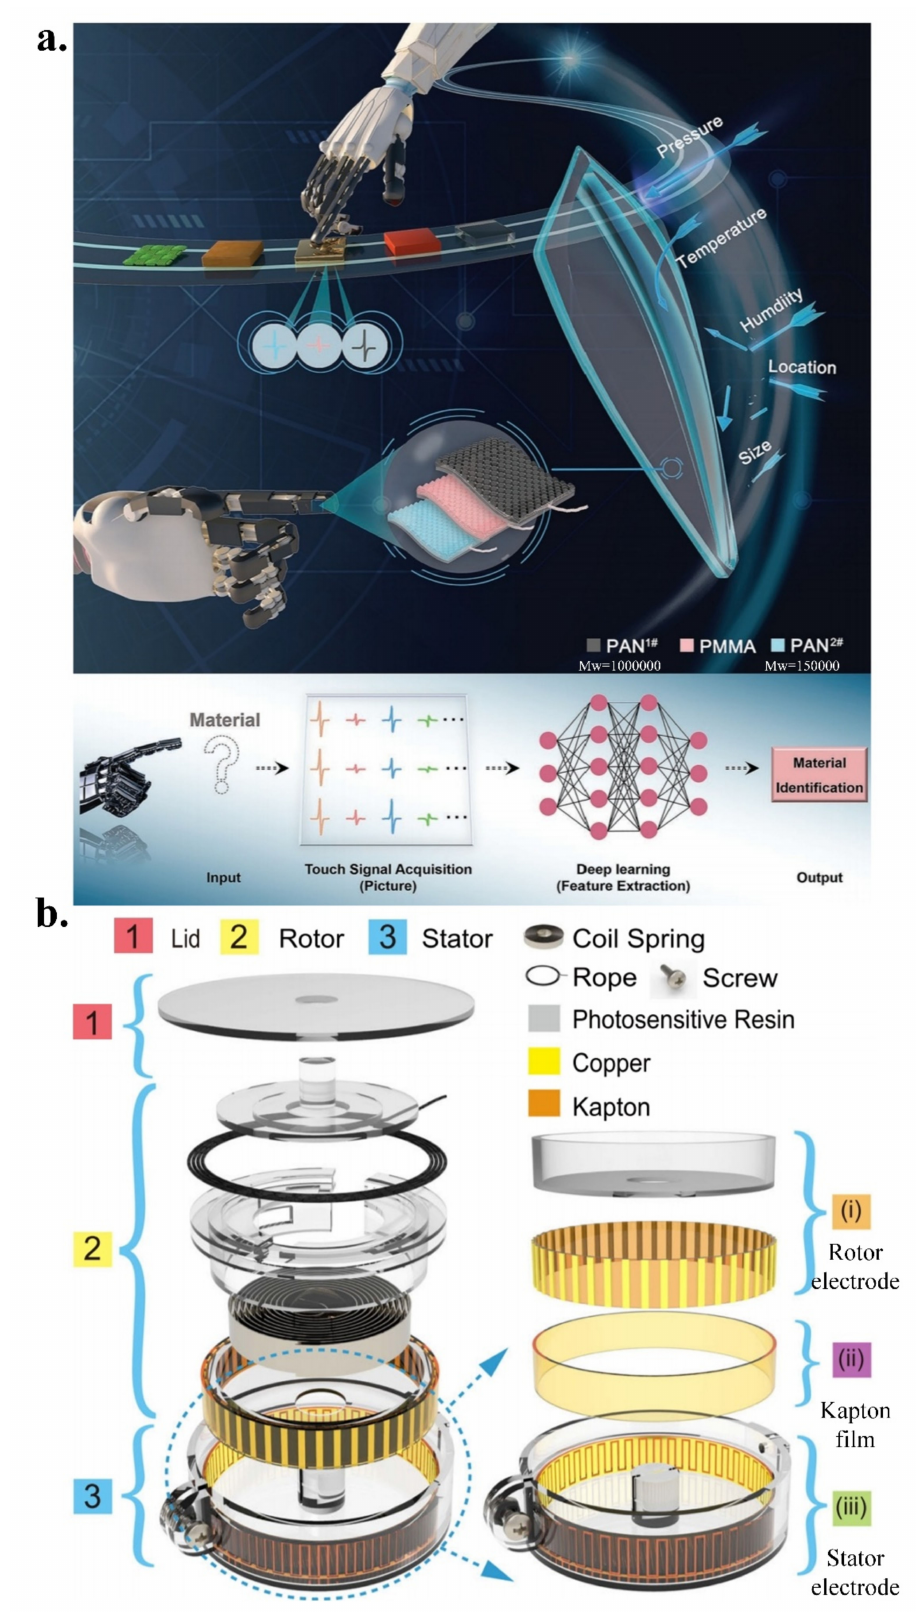
Figure 4. ( a ) Intelligent tactile sensing system combining TENGs and deep learning technology; reproduced with permission from Wiley (2022) [105]; ( b ) Badge-reel-like, stretchable, wearable, self-driving sensor, and its system; reproduced with permission from Springer Nature (2021)